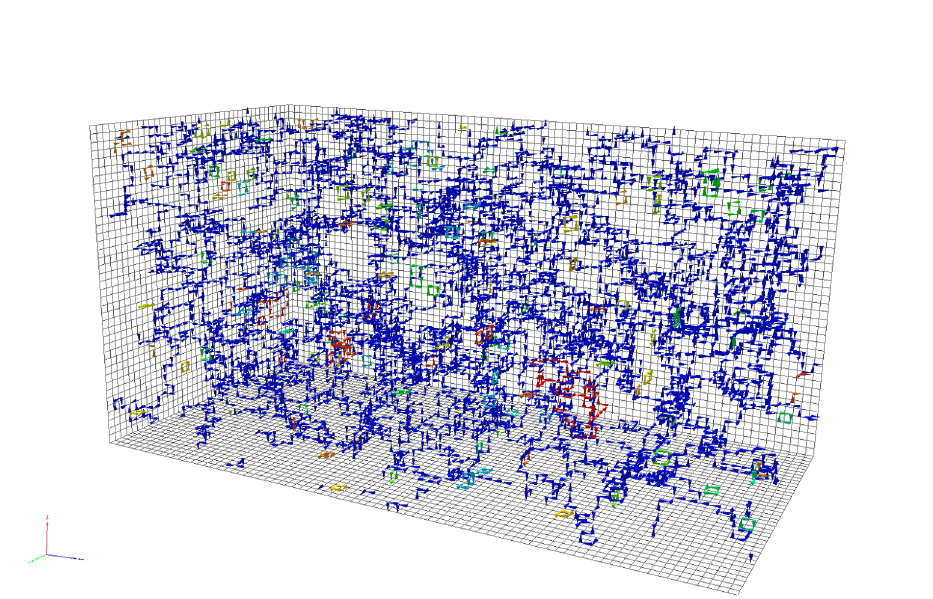
Figure 3. The centre-vortex structure of a ground-state vacuum field configuration in dynamical 2 + 1 flavour QCD with m π = 156 MeV. Symbols are as described in figure 2. ( Click to activate.